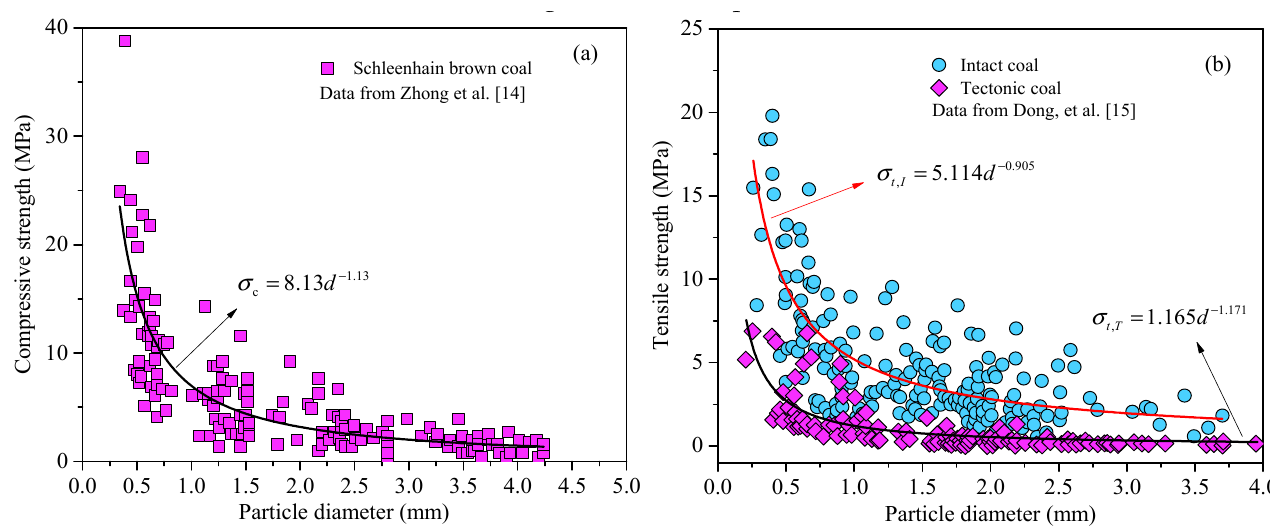
Figure 5. The relationship between mechanical strength and particle size of coal particles. ( a ) Compressive strength; ( b ) tensile strength. The morphologies of reconstituted coal formed by particles with different size distri- butions are shown in Figure 6. The surfaces of coal samples formed by coarse particles are rough and the particles are not tightly combined (Figure 6a). Meanwhile, the surfaces of samples formed by medium (Figure 6b) and fine particles (Figure 6c) are smoother. The coal samples with more coarse particles have rougher surfaces, while those with more fine particles have smoother surfaces (Figure 6d–h).